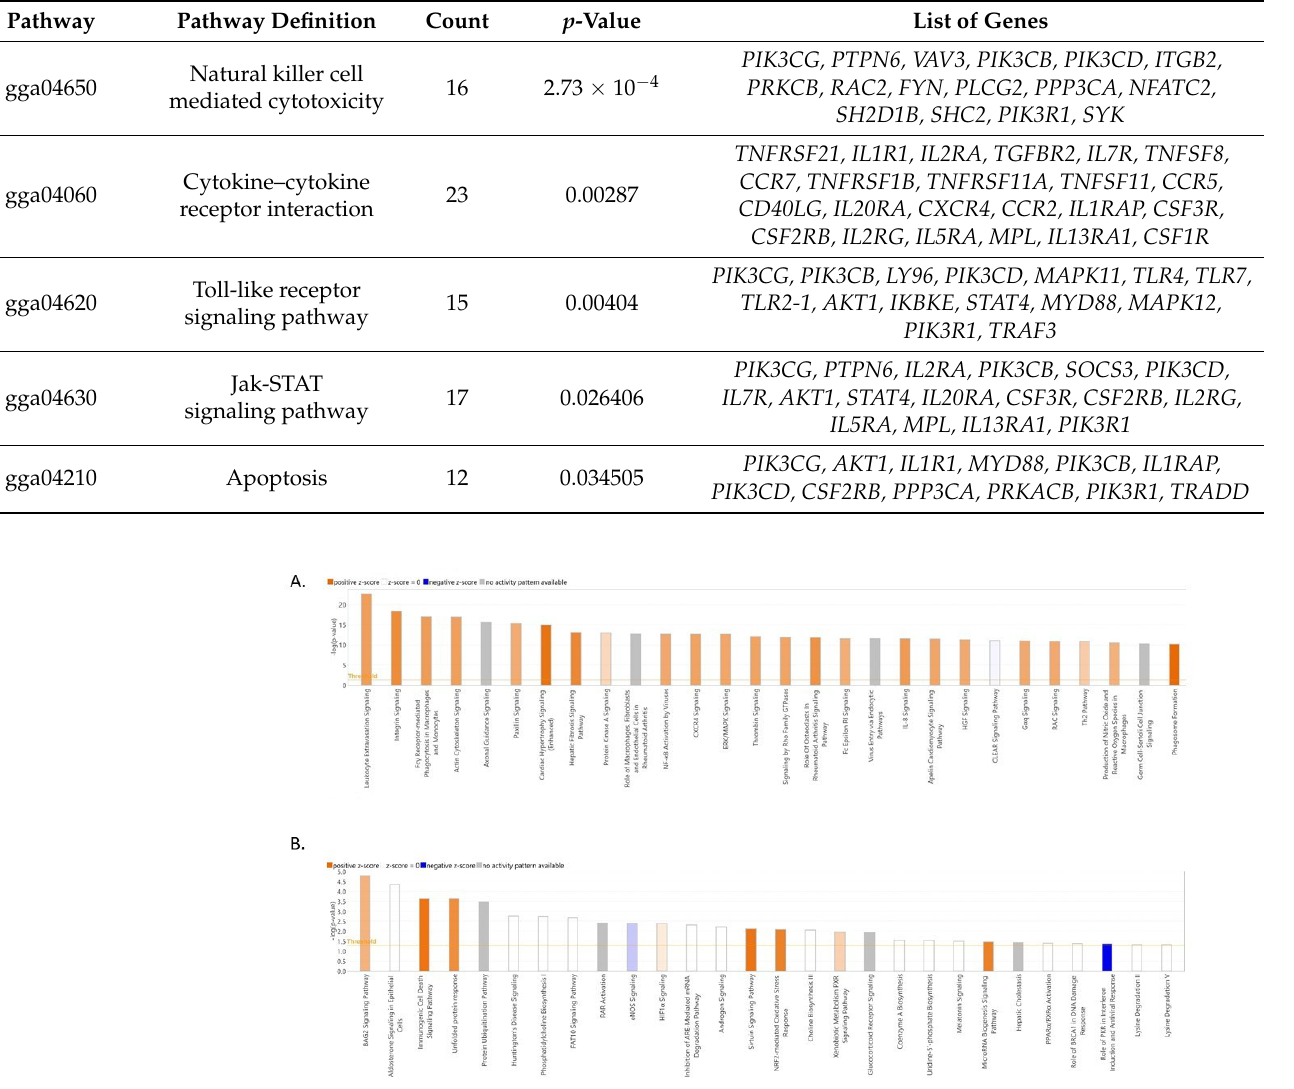
Figure 5. Ingenuity pathway analysis. ( A ) The biological pathways highlighted in gene expression in commercial birds. ( B ) The biological pathways highlighted in gene expression in indigenous birds. Orange—pathway activation; blue—pathway